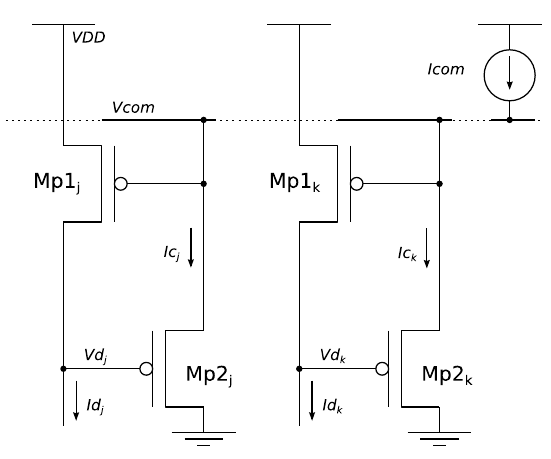
Figure 1. WTA circuit proposed by Lazzaro.